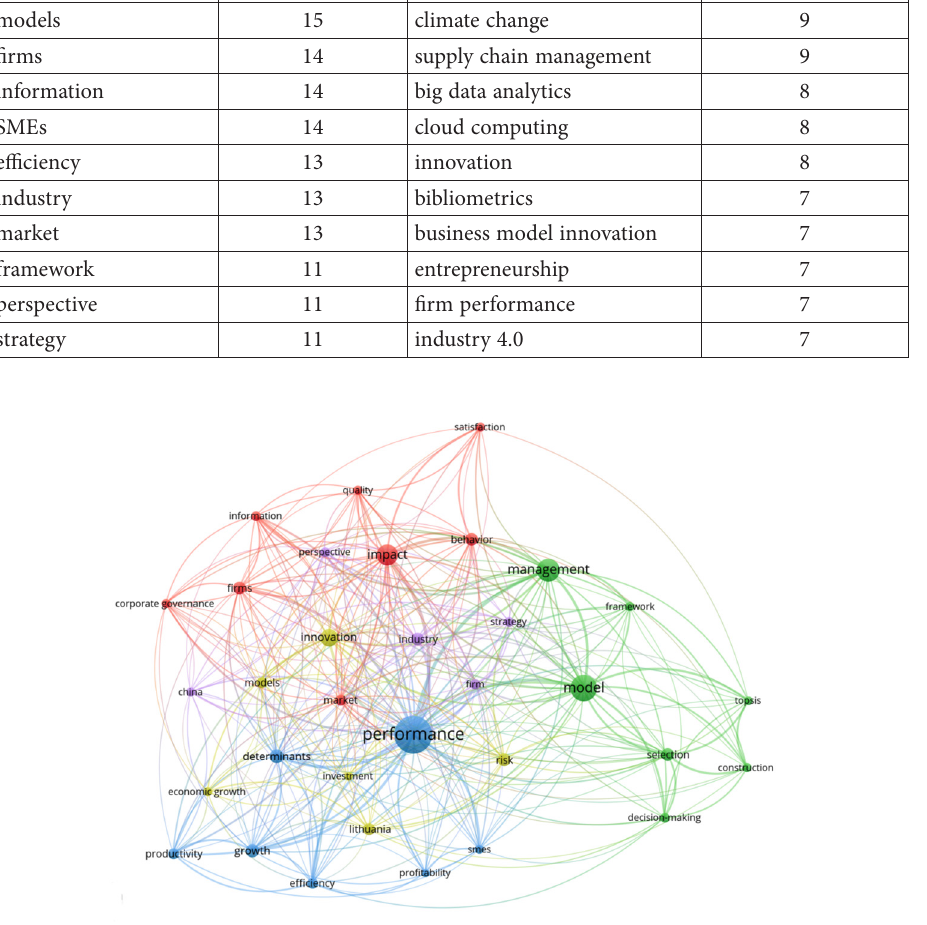
Figure 5. Keywords co-occurrence of